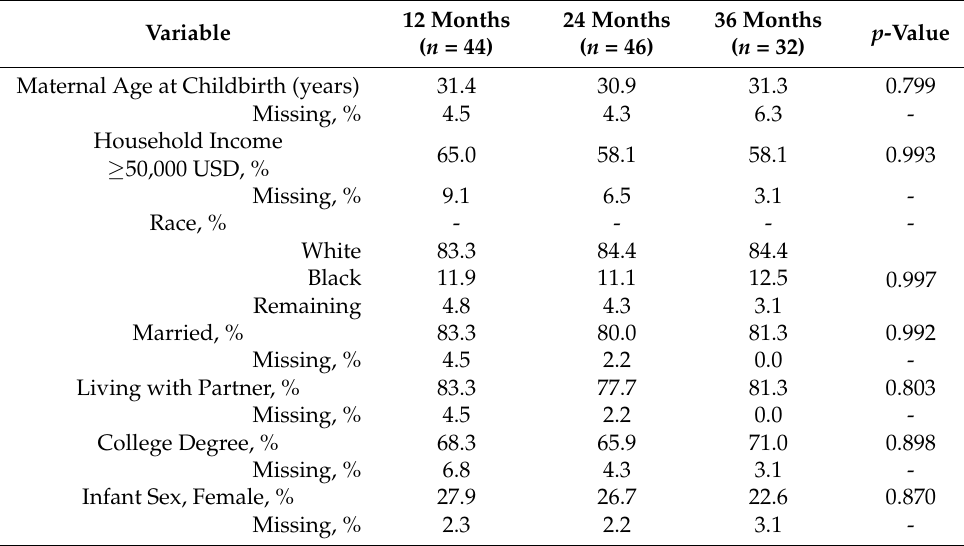
Table 1. Participant characteristics by child